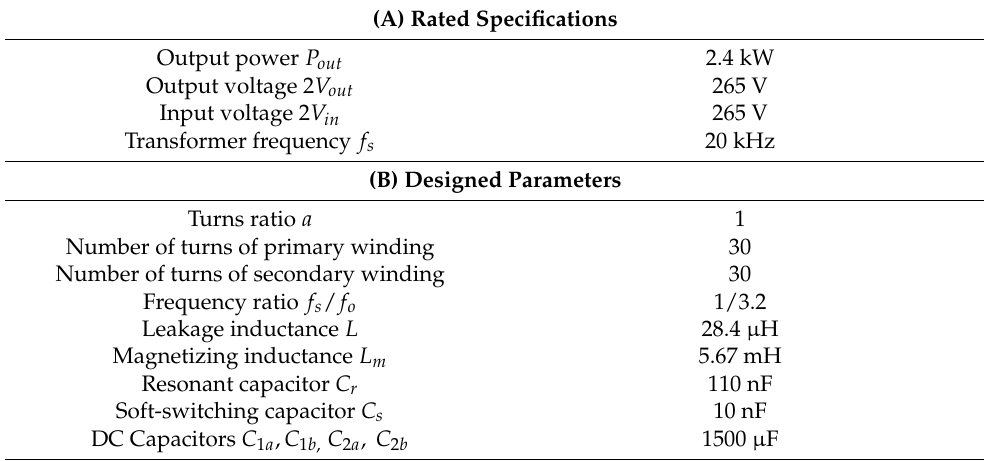
Table 2. Specifications and designed parameters of proposed apb